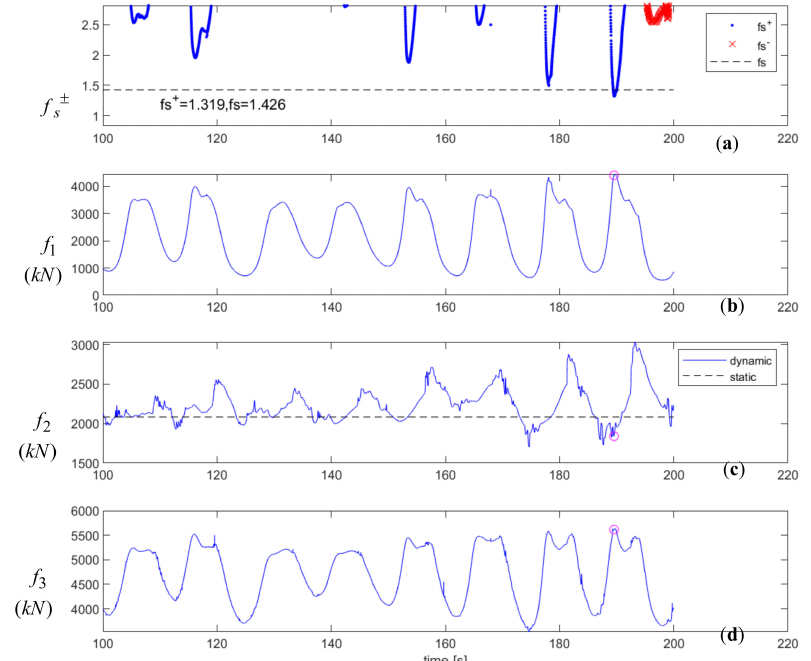
Figure 12. Comparisons of time histories of the safety factors against sliding and their loads for case 4. ( a ) The safety factors against sliding among f s + ( . ), f s − ( × ) and f s (—); ( b ) The forces f 1 (—); ( c ) The forces